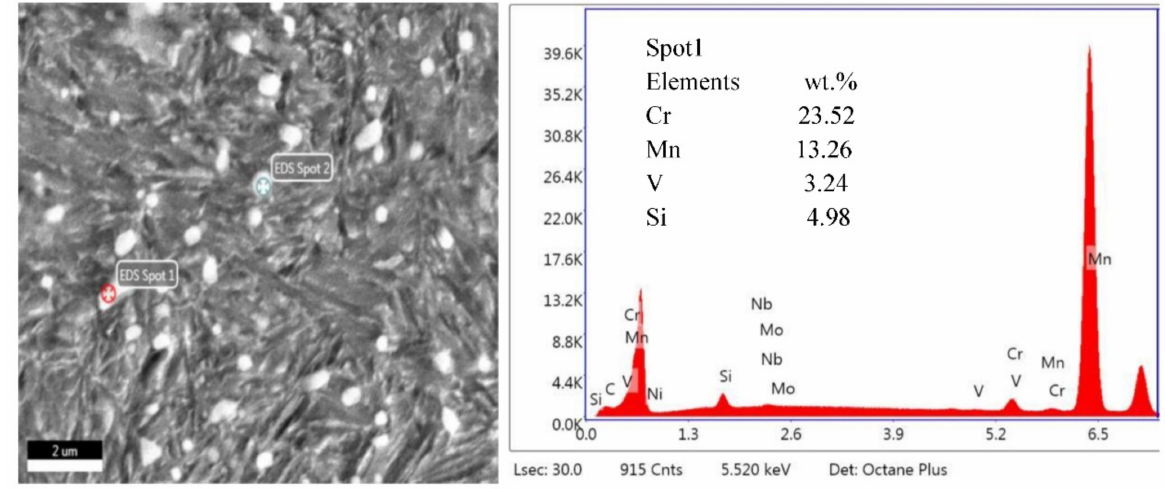
Figure 6. Energy-dispersive spectrometer analysis of undissolved carbides (210 ◦ C × 24 h).